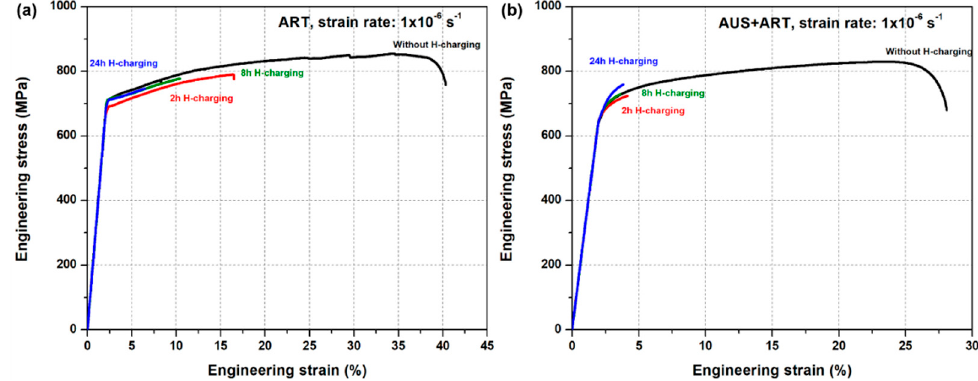
Figure 6. Evaluation of mechanical degradation by ex-situ slow strain rate tensile test at a strain rate of 10 − 6 s − 1 in ( a ) ART specimen; and ( b ) AUS + ART specimen.